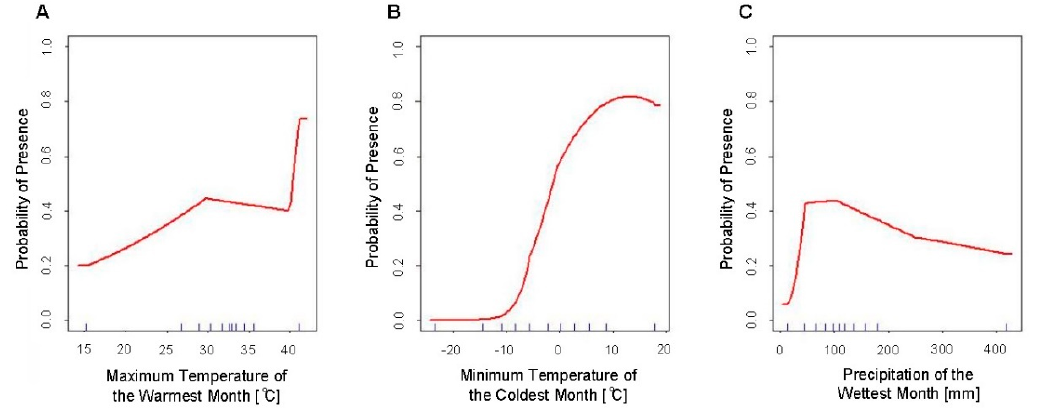
Figure 5. Response curves of the variables used in the final SDMs of the Ae. aegypti (Model 2a) using occurrence records excluding the VZL data, showing predicted habitat suitability to ( A ) the maximum temperature of the warmest month (Bio5), ( B ) the minimum temperature of the coldest month (Bio6) and ( C ) the precipitation of the wettest month (Bio13).